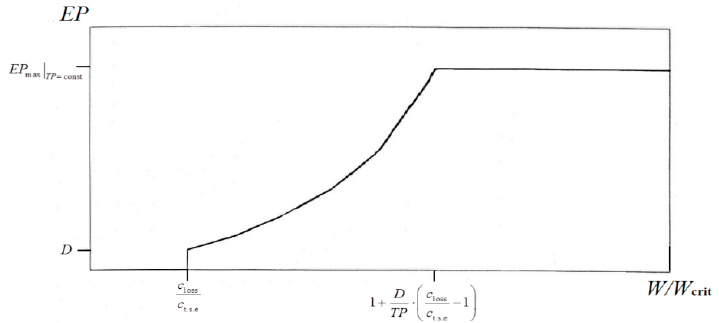
Figure 4. Correlation between the economic potential of solar energy for photovoltaic conversion, EP , and the relative energy generation, W / W crit .